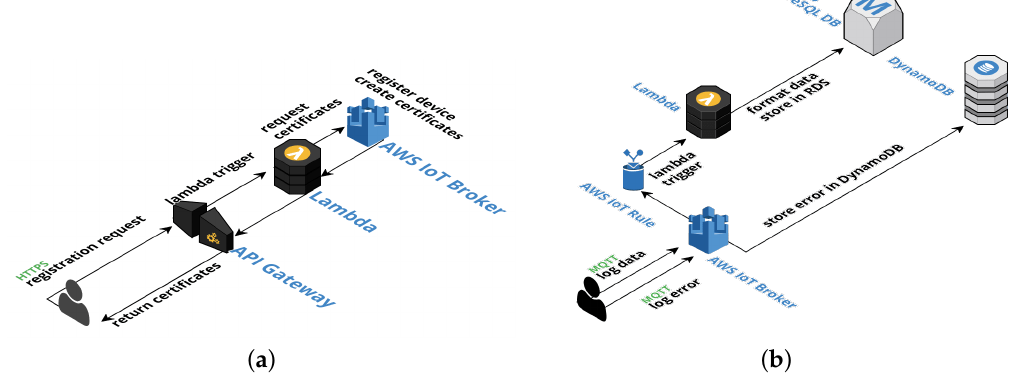
Figure 4. Register new device and error logging flow and architecture of the prototype. ( a ) Register new device flow and architecture. ( b ) Data and error logging flow and